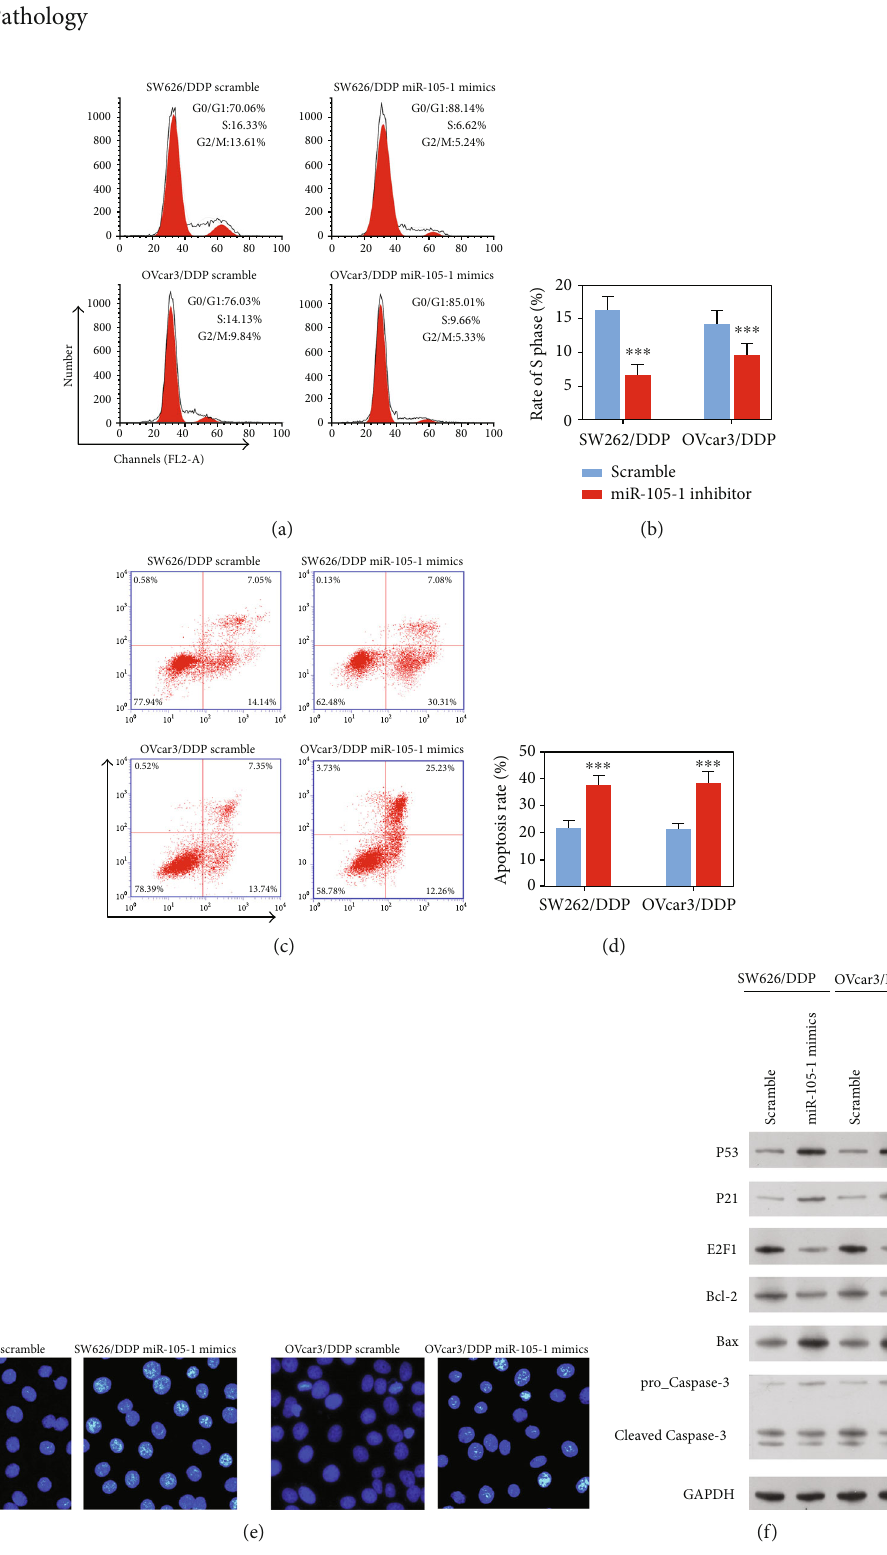
Figure 6: Upregulation of Hsa-miR-105-1 reduced the cisplatin resistance of SW626/DDP and OVcar3/DDP cells. SW626/DDP and OVcar3/DDP cells were transfected with the scramble or Hsa-miR-105-1 mimics and then stimulated with cisplatin (10 μ g/mL). (a, b) The cell cycle distributions of SW626/DDP and OVcar3/DDP cells were detected by fl ow cytometry. (c, d) The percentages of apoptotic SW626/DDP and OVcar3/DDP cells were determined by annexin V-FITC/PI staining and fl ow cytometry. (e) Cell apoptosis was detected by Hoechst staining. (f) The levels of P53, P21, E2F1, Bcl-2, Bax, and caspase-3 protein expression were examined by western blotting. ∗∗∗ P < 0 : 01 and paired t